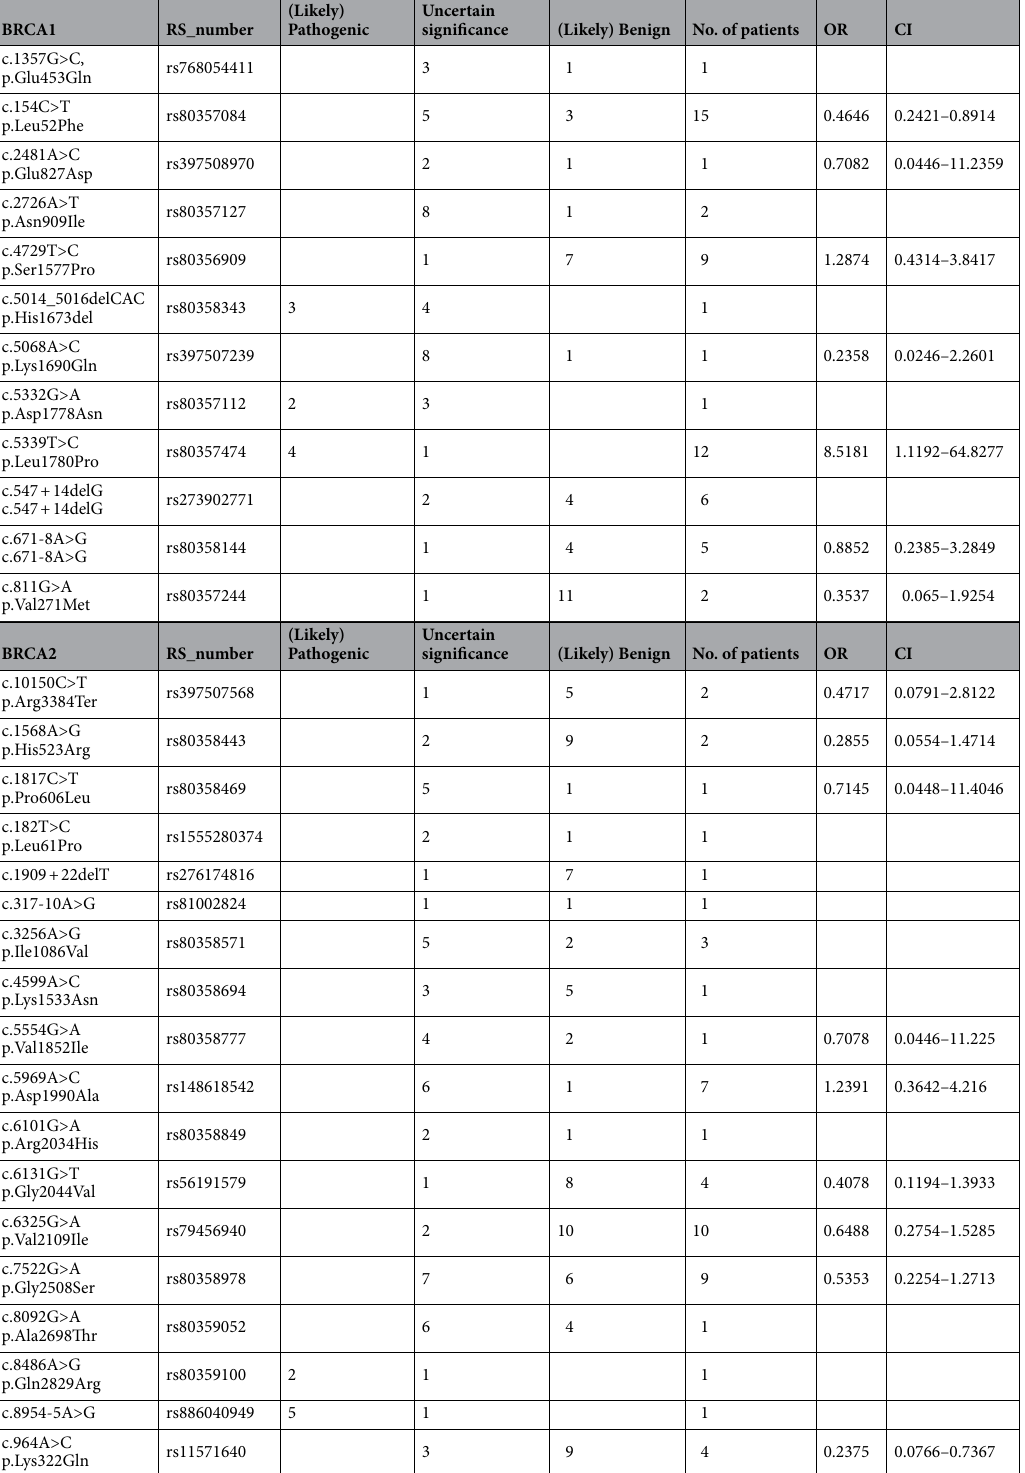
Table 3. Conflicting interpretations of